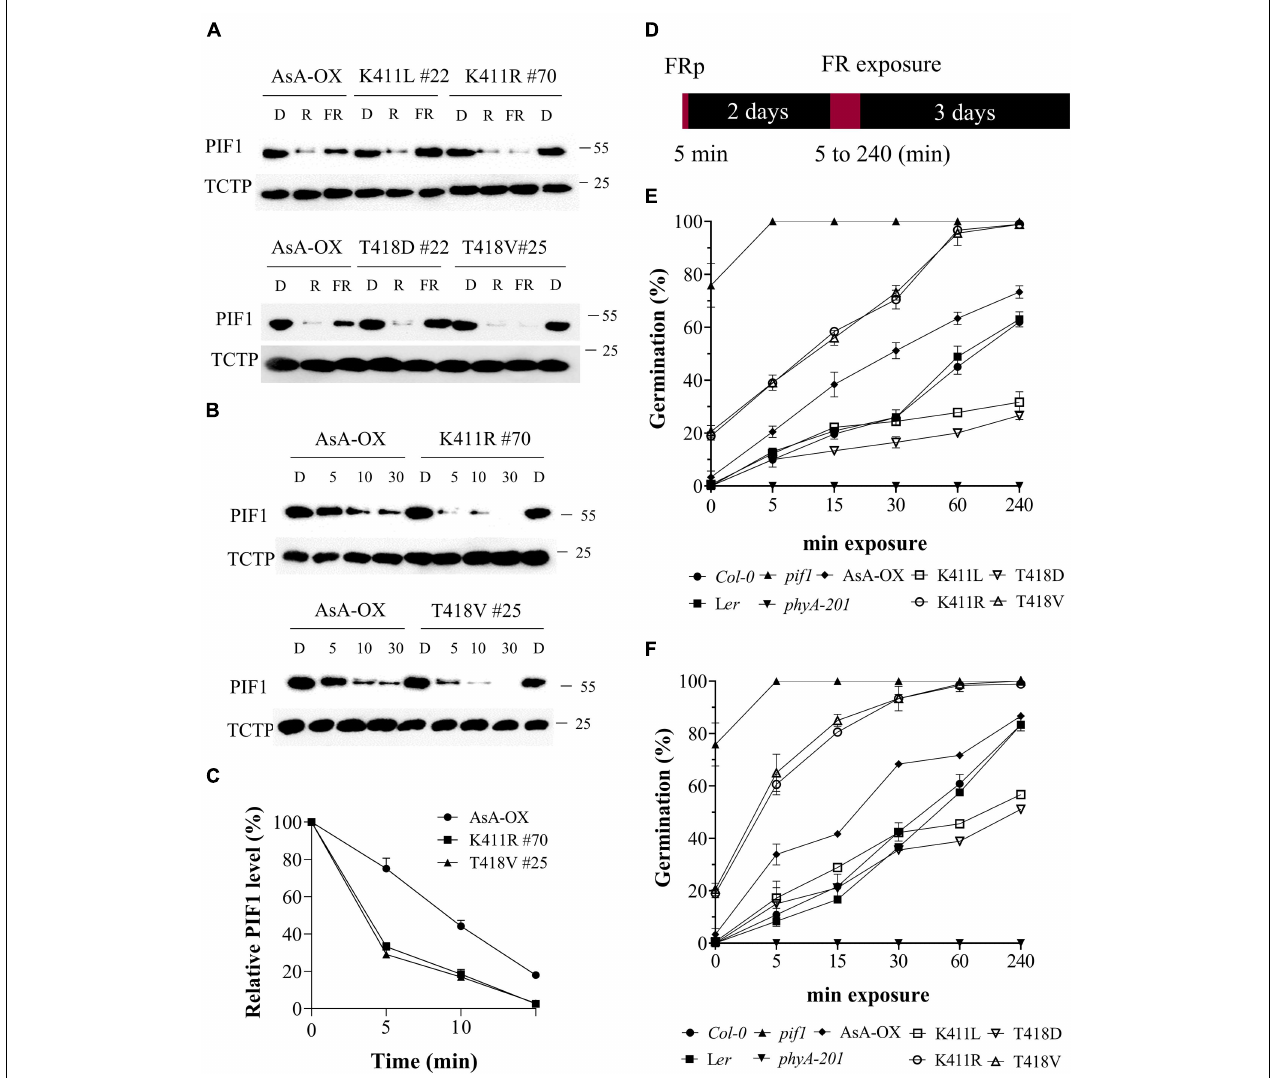
FIGURE 6 | FR-induced degradation of PIF1 and germination analysis of transgenic plants with AsphyA kinase mutants. (A) Light-induced degradation of PIF1. Four-day-old dark-grown seedlings were kept in the dark or exposed to either R (20 µ mol · m − 2 · s − 1 ) or FR (20 µ mol · m − 2 · s − 1 ) light for 5 min, before collecting samples for protein extraction. Loading controls (TCTP) are shown in the lower panels. Transgenic plants of two AsphyA mutants with lower kinase activity (K411L and T418D) were included to compare with those of two mutants with higher kinase activity (K411R and T418V). (B) Time-dependent degradation of PIF1 under FR light. Four-day-old dark-grown seedlings were kept in the dark or exposed to FR (20 µ mol · m − 2 · s − 1 ) for the time indicated (5, 10, and 30 min), before protein extraction. (C) Relative PIF1 protein levels in (B) . Relative intensities of PIF1 protein bands were estimated from the blots using ImageJ, assuming dark samples as 100%. The intensities of TCTP protein bands were used for normalization. Data represent means ± SD from three independent measurements. (D–F) FR-induced (i.e., phyA-dependent) seed germination. Light scheme for the germination assay is shown in (D) . Seeds were irradiated with FR pulse (5 µ mol · m − 2 · s − 1 for 5 min) and incubated at 21 ◦ C for 2 days in the dark. Seeds were then exposed with FR fluence rates of 0.5 µ mol · m − 2 · s − 1 (E) or 5 µ mol · m − 2 · s − 1 (F) for the time indicated (0, 5, 15, 30, 60, and 240 min), and further incubated for 3 days in the dark. Germination percentages were calculated from the number of germinated seeds per total number of plated seeds. In addition to L er , phyA-201 and AsA-OX, Col-0 and pif1 (Col-0 background) plants were included as controls. Error bar represents SD from three independent